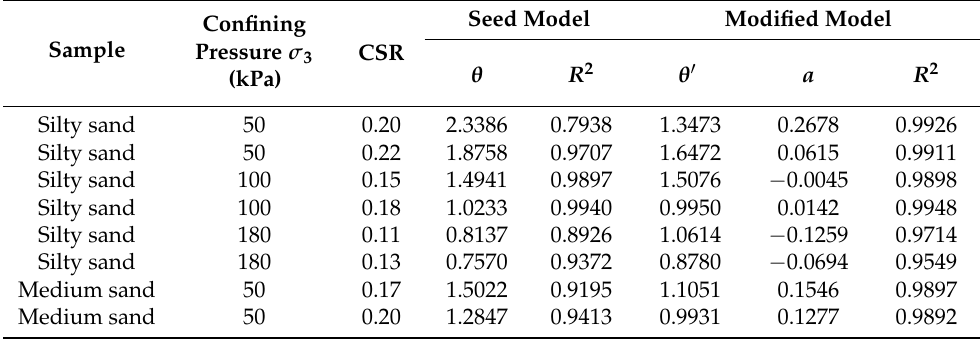
Table 8. Fitting parameters and determinable coefficients of seed model and modified